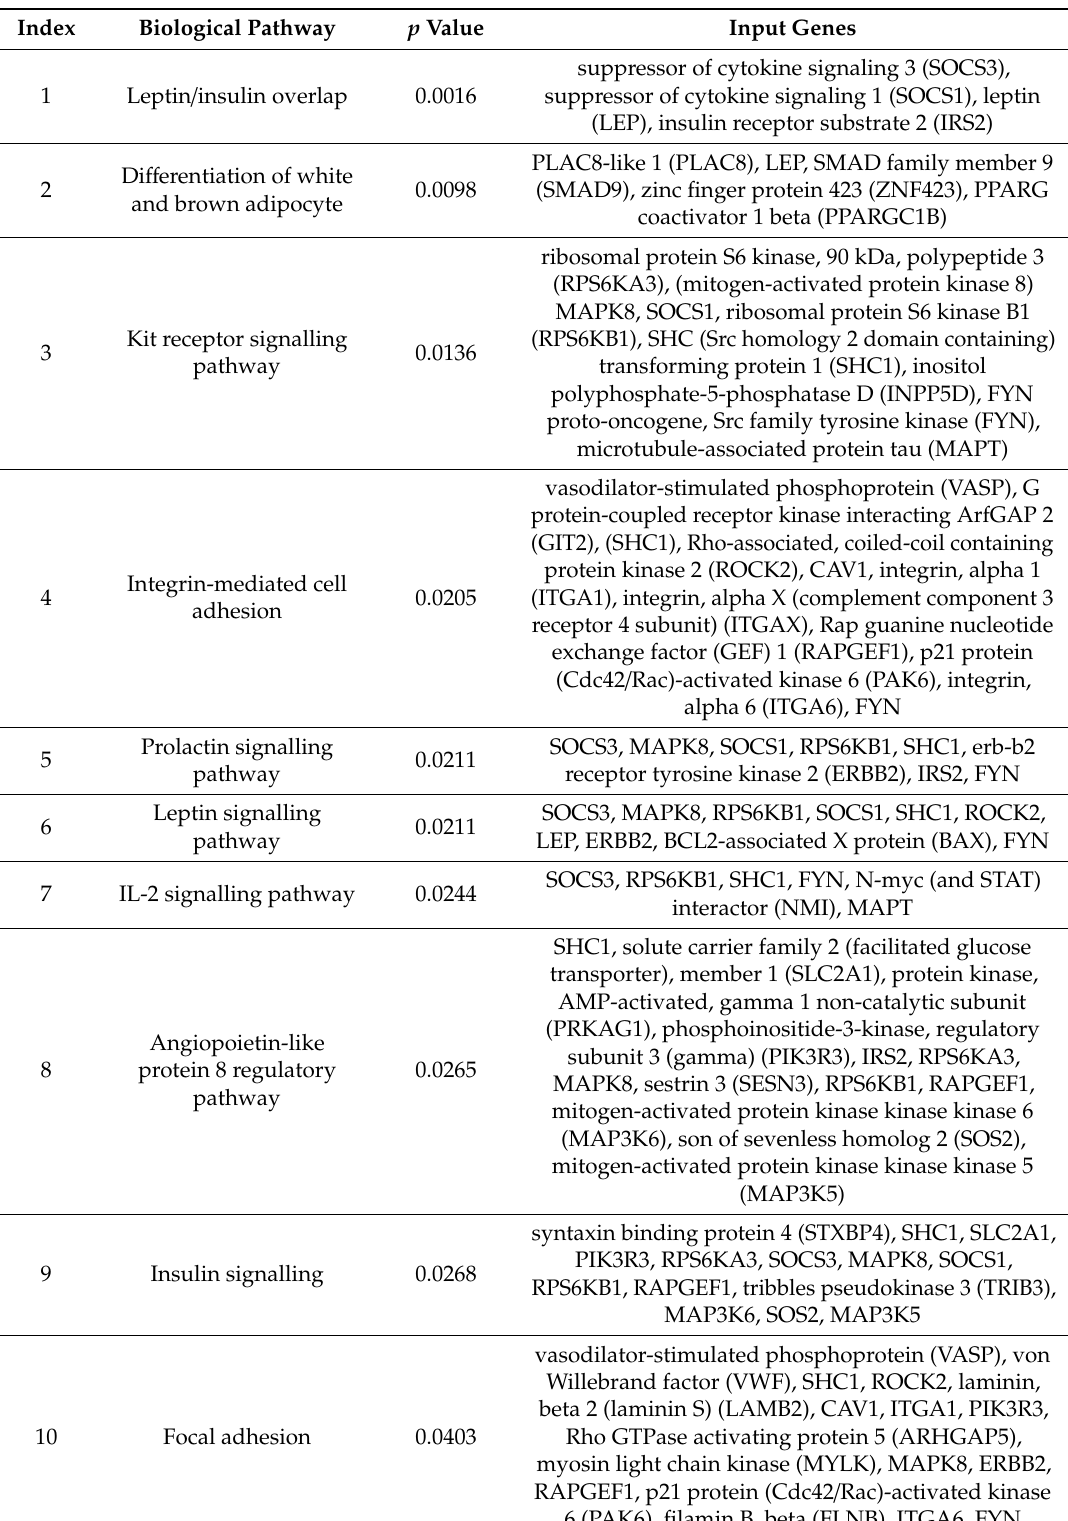
Table 2. Top 10 pathways associated with di ff erentially expressed genes after 3 nM bisphenol A (BPA) treatment of BeWo cells using the WikiPathways 2019 Human database (Enrichr). The most significantly regulated pathway is leptin / insulin